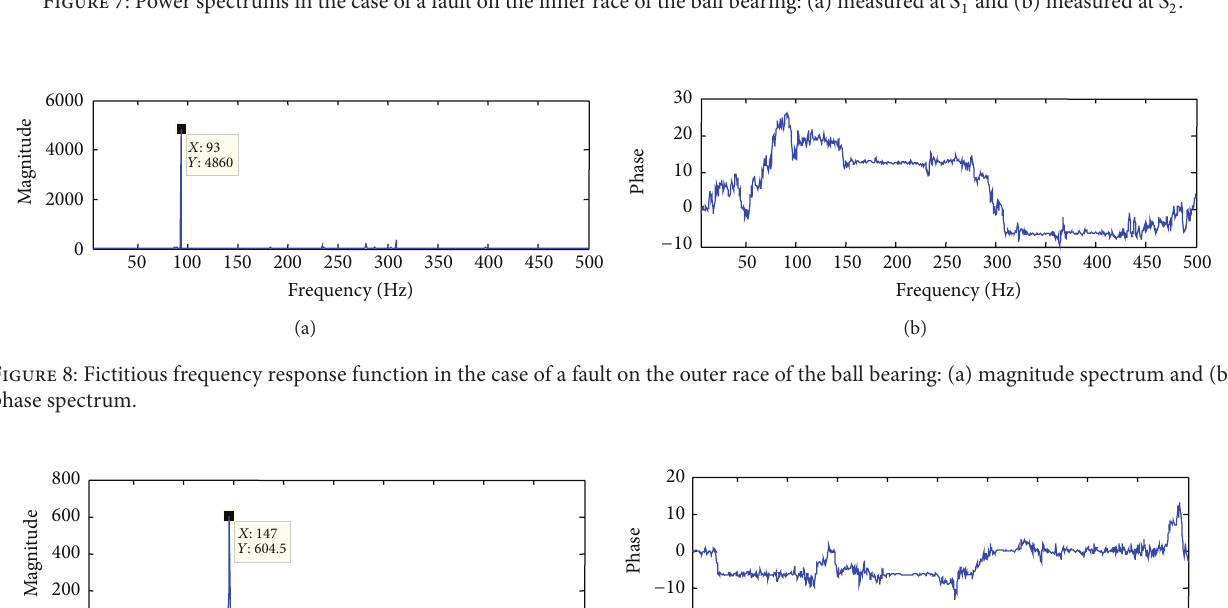
Figure 7: Power spectrums in the case of a fault on the inner race of the ball bearing: (a) measured at 𝑆 1 and (b) measured at 𝑆 2 .